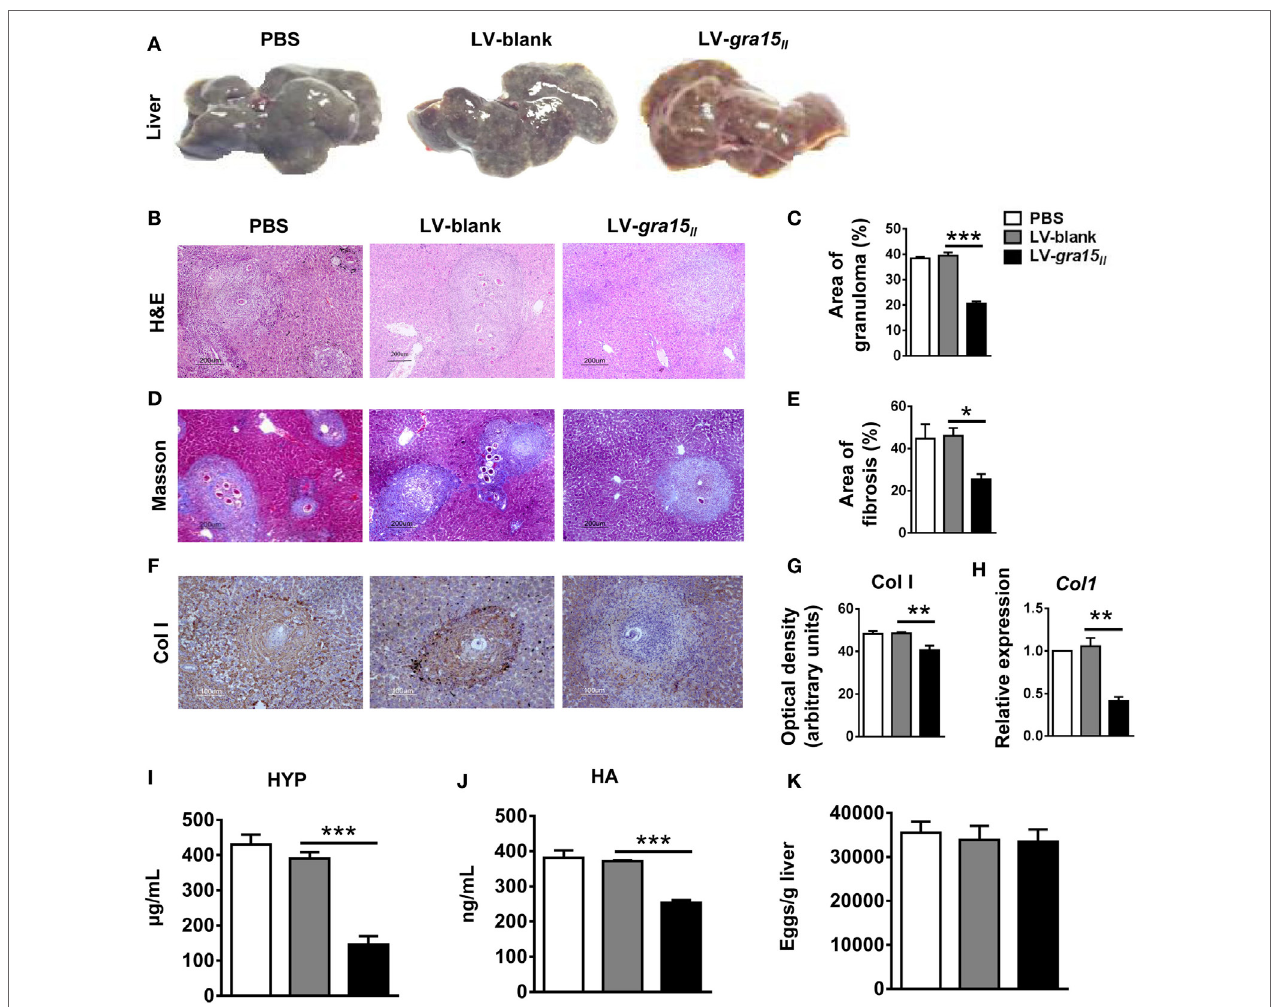
FigUre 4 | Lentiviral vector- gra15 II delivery ameliorated hepatic granulomas and fibrosis in schistosomiasis mice. Mice were killed under euthanasia at 8 weeks post-infection, and then the blood and the liver were collected. The appearances of liver were exhibited (a) . Liver tissue section was stained with hematoxylin and eosin and the granulomas area was showed with quantitative analysis (B,c) . Liver tissue section was stained with Masson and the fibrosis area was showed with quantitative analysis (D,e) . Col Ι protein level in liver was evaluated by IHC with quantitative analysis of optical density (F,g) and Col Ι gene expression in liver was analyzed by quantitative real-time PCR (h) . The HYP content in liver was checked by hydroxyproline assay kit (i) . Sera hyaluronic acid level was assayed by enzyme-linked immunosorbent assay (J) . Eggs in liver tissue were counted under light microscope (K) . Data represent mean ± SD from multi-group experiments. * p < 0.05, ** p < 0.01, and *** p < 0.001 ( n = 4 each